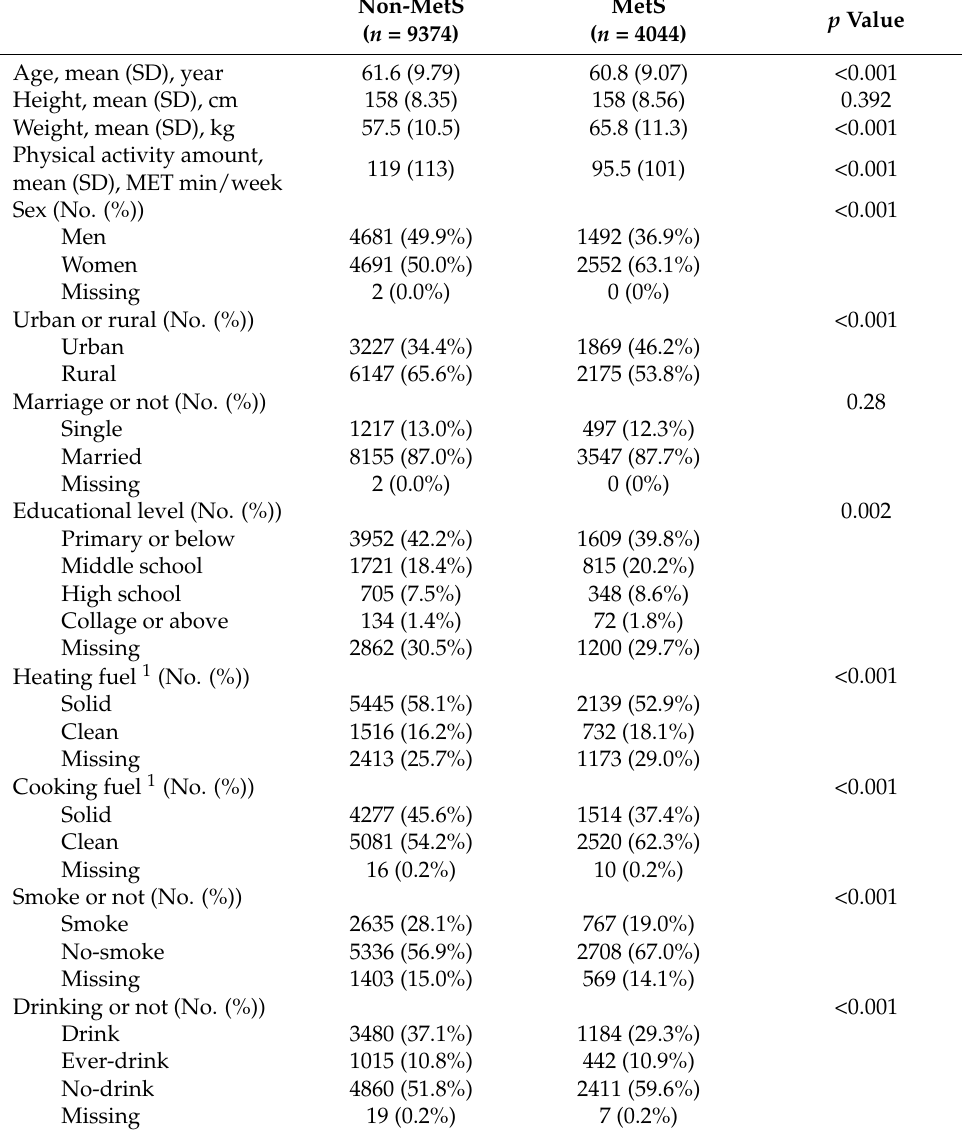
Table 1. Characteristic of the